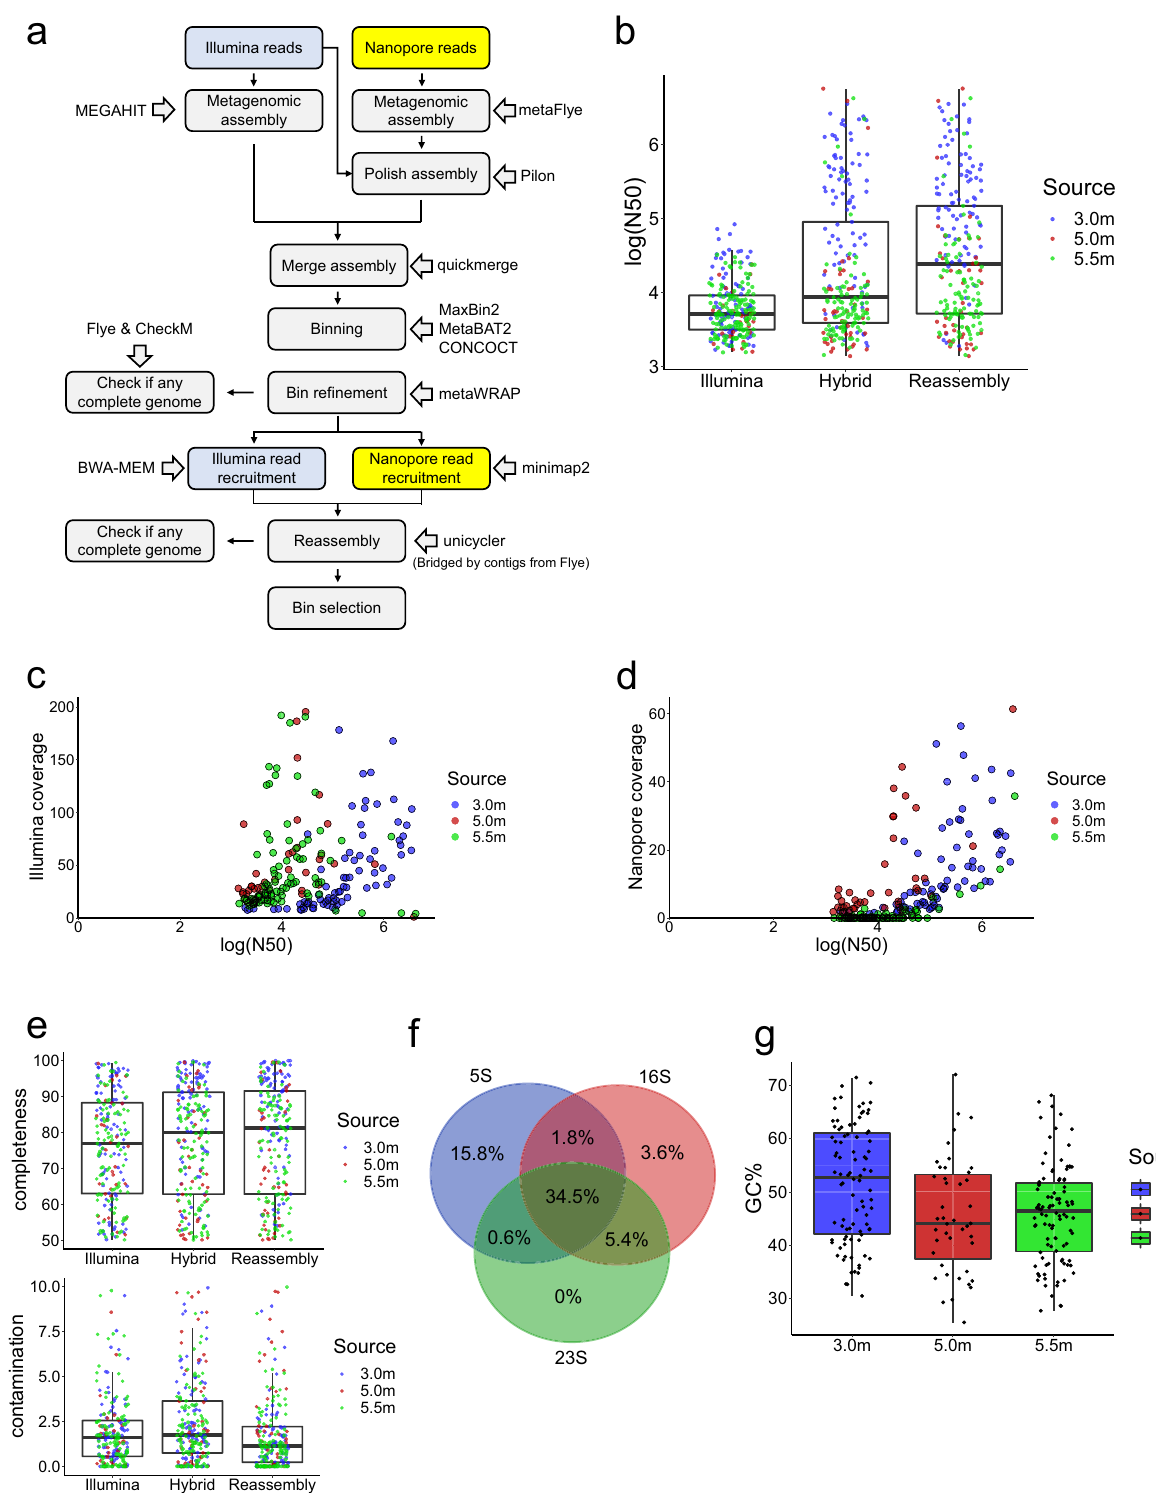
Fig. 1 Recovery of genomes from Lake Shunet using long- and short-read sequencing. a The work fl ow for assembling metagenome-assembled genomes (MAGs). b The value of log (N50) at 3.0, 5.0, and 5.5 m depth using SRs only, combining SRs an LRs (Hybrid), and reassembly of bins using the hybrid method. c Scatter plot of SR coverage and log (N50) in the fi nal Shunet MAG collection (Reassembly). d Scatter plot of LR coverage and log (N50) in the fi nal Shunet MAG collection (Reassembly). e The completeness and contamination of MAGs recovered from the hybrid assembly with reassembly. f Venn diagram from the ratio of MAGs of the hybrid assembly, containing 5 S, 16 S, and 23 S rRNA gene sequences. g The GC ratio of MAGs recovered from the 3.0, 5.0, and 5.5 m depth datasets. For each box plot, the center line represents median, box limits represent upper and lower quartiles, and whisker represents 1.5X interquartile